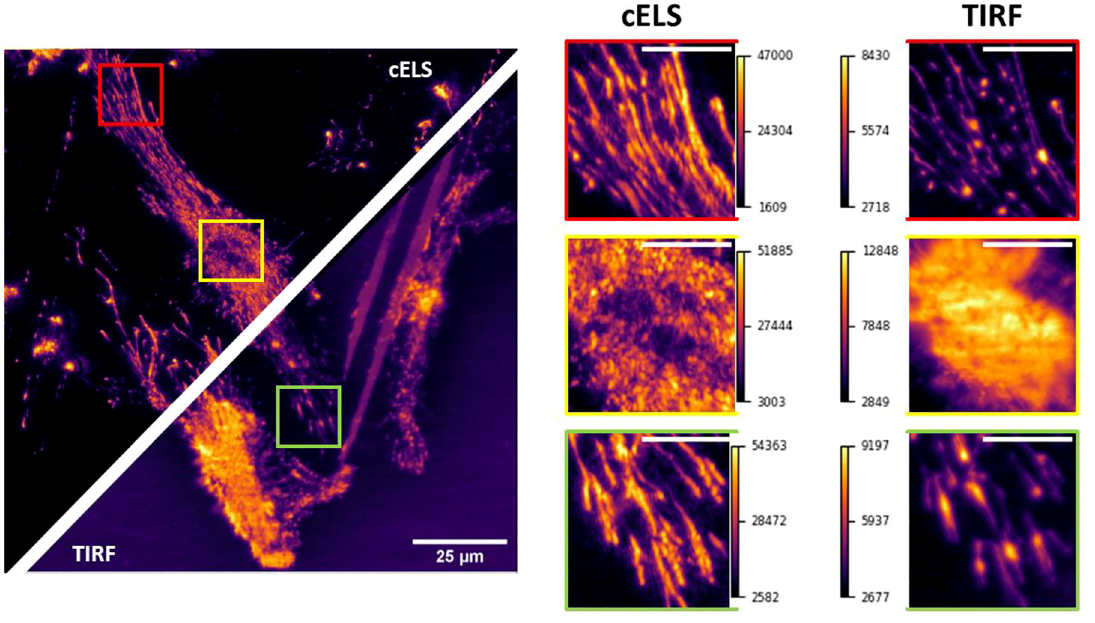
Figure 6: Comparison between cELS and TIRF images of Hela cells, scale bar 25 μ m. Three different regions of interest enclosed by red, yellow, and green boxes are blown-up and provided alongside. The yellow box shows the nucleus region of the cell whereas the red and green boxes are the filaments, scale bar 8 μ m. The color bars given alongside the magnified regions indicate the pixel